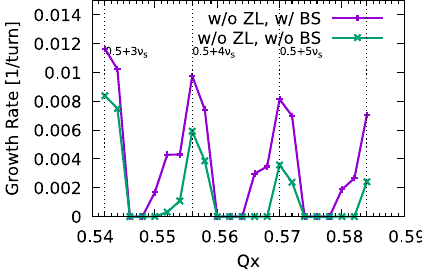
FIG. 3. The horizontal beam size growth rate versus horizontal tune with and without longitudinal coupling impedance (ZL). Beamstrahlung (BS) effect is turned on.